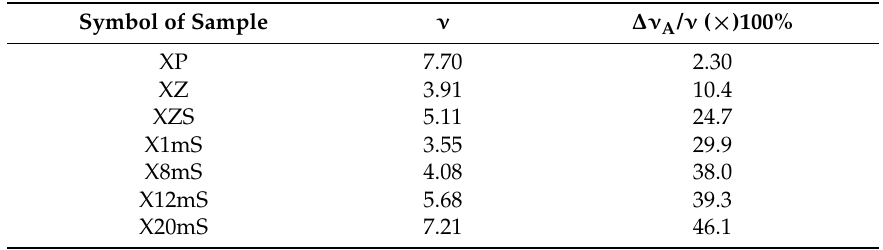
Table 3. The crosslink density of carboxylated butadiene-acrylonitrile rubber (XNBR) vulcanizates. Symbol of